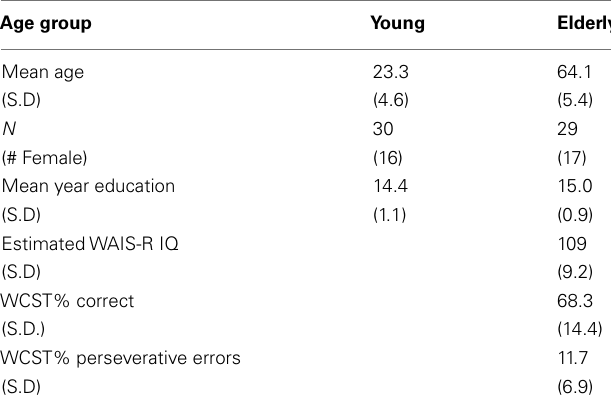
Table 1 | Demographic information of